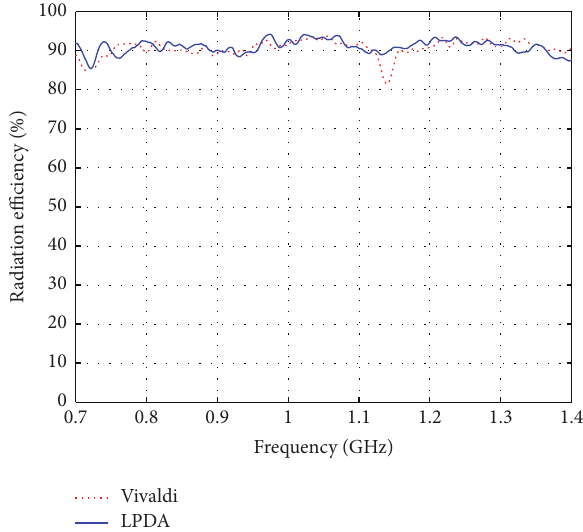
Figure 9: Measured radiation efficiency of antennas using one- antenna method.